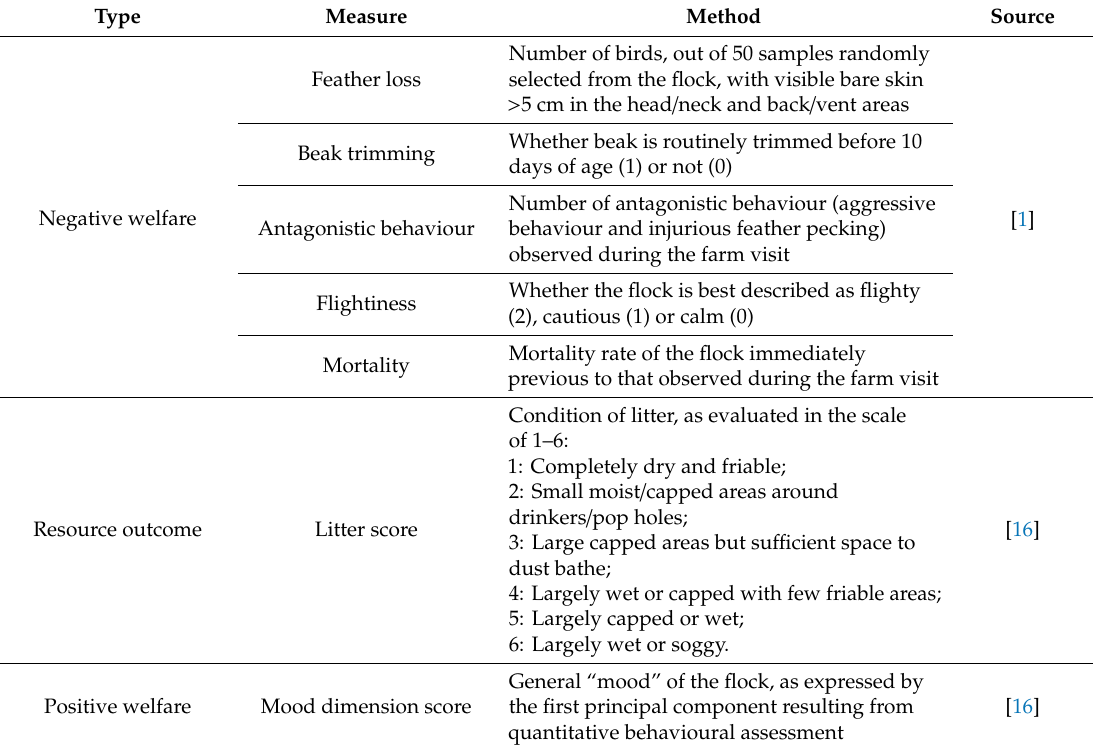
Table 2. Outcome measures used for validation of resource tier